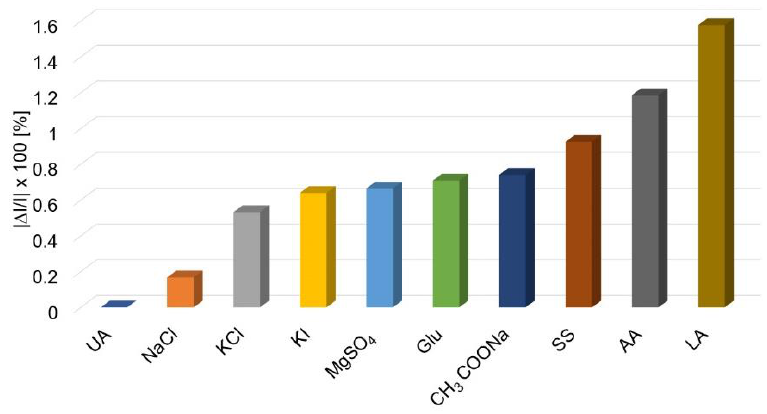
Figure 14. Average percentage errors for UA optical detection using TAmPP, introduced by dif- ferent interferences. different